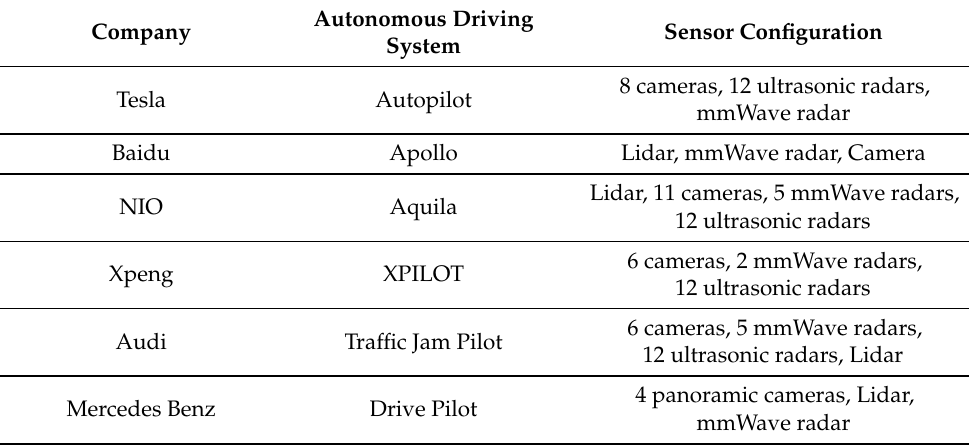
Table 2. Autonomous driving sensor solutions of some manufacturers [30–35].